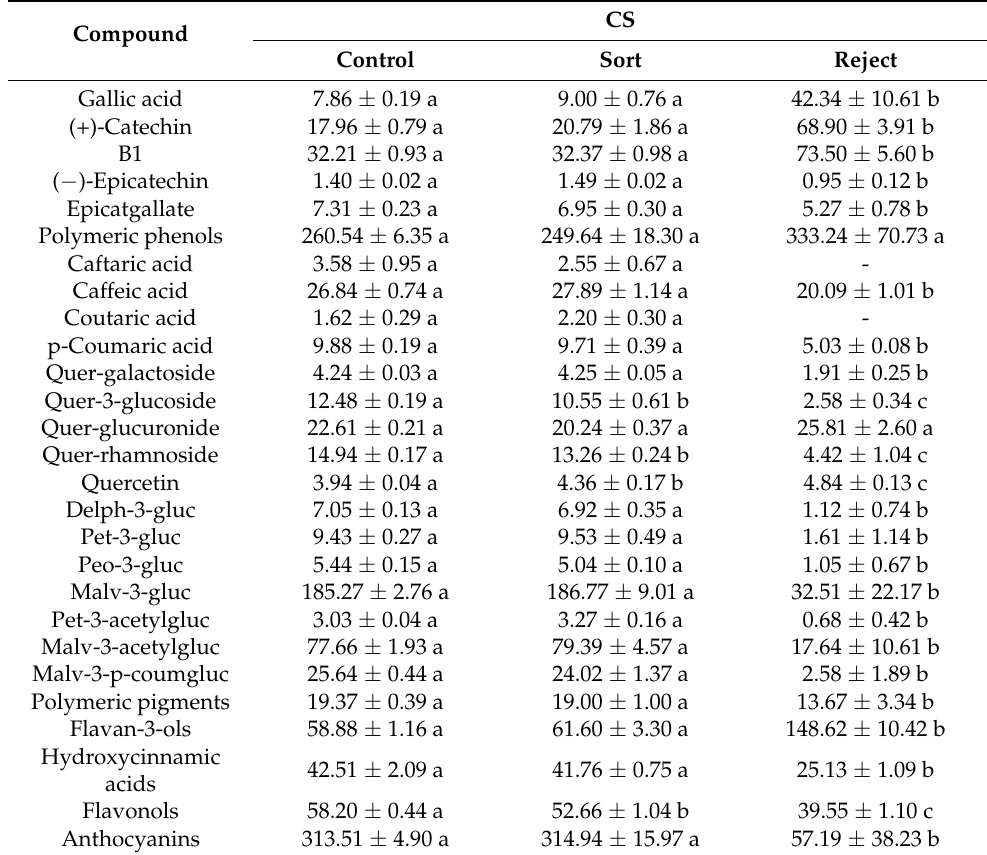
Table 9. Concentration (mg/L) of phenolic compounds in Cabernet Sauvignon wines determined by RP-HPLC from samples taken around six months after